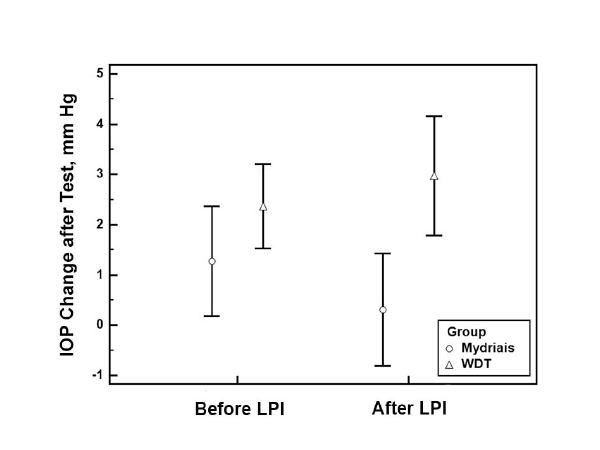
Figure 1. Comparison of intraocular pressure (IOP) changes after the water-drinking test (WDT) and pharmacologic mydria- sis in primary angle closure suspect patients before and after laser peripheral iridotomy